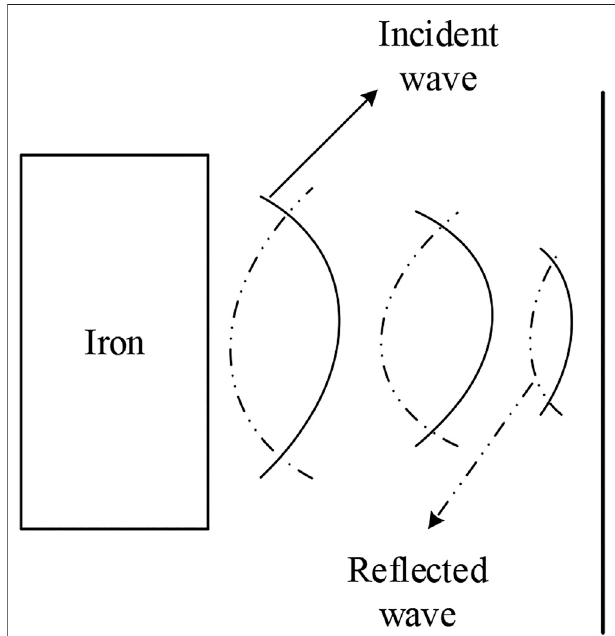
FIGURE 3 | Insulating oil vibration propagation.